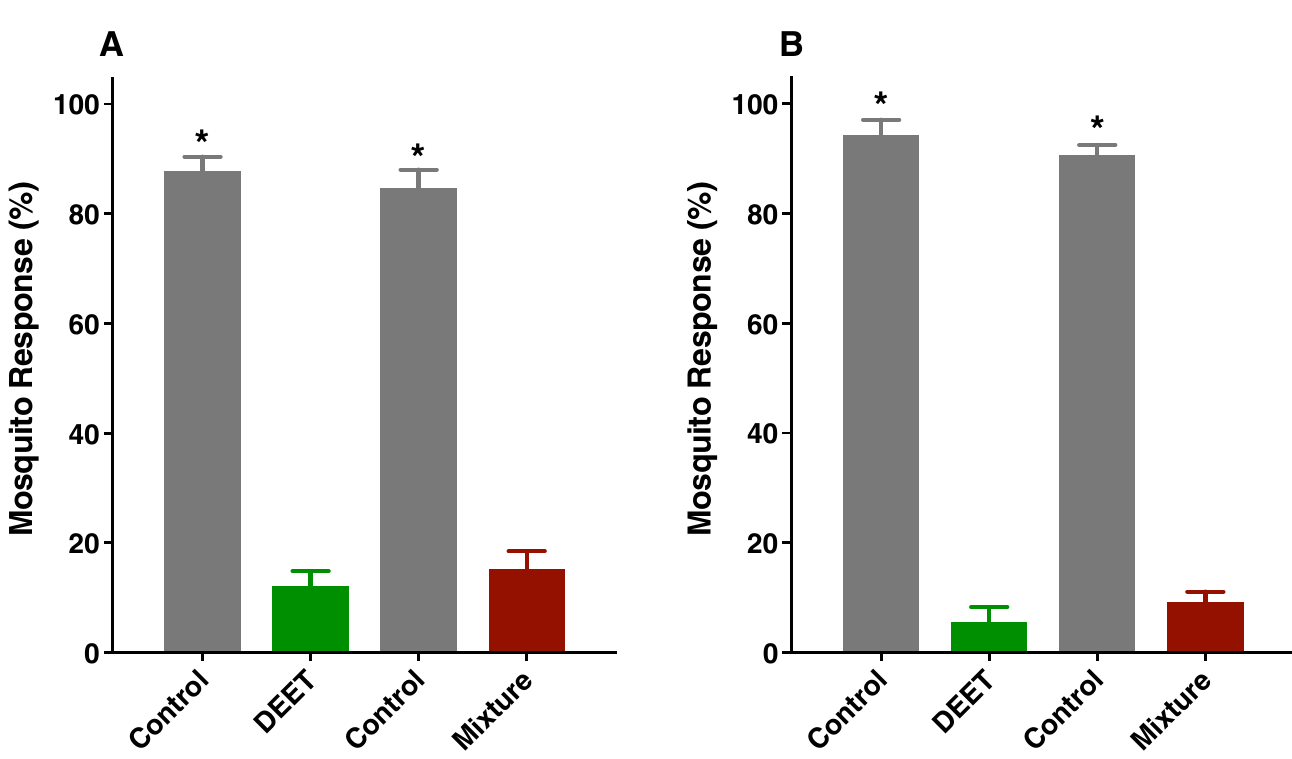
Fig 3. Repellence activity elicited by mixtures of methyl dihydrojasmonate and lilial at (A) 1% and (B) 5% compared with responses to DEET at the same concentration. Data were normalized and expressed as mean ± SEM. Asterisks denote significant differences of transformed data (Student t test, P < 0.05). The number of replicates were (A) mixture, n = 13; DEET, n = 12; (B) mixture and DEET, n =